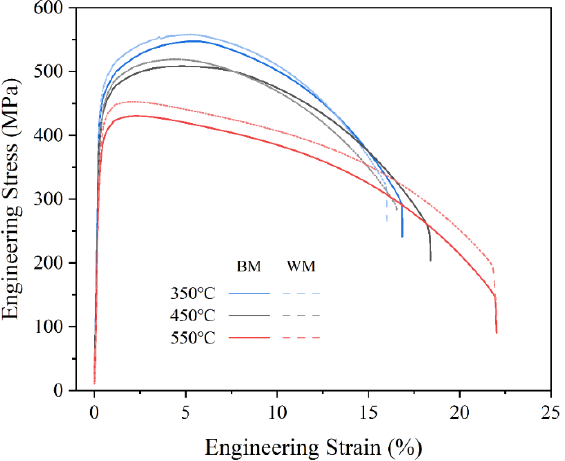
Figure 3. Engineering stress–strain curves of 2.25Cr1Mo0.25V steel BM and WM at elevated temperatures. Table 2. Tensile properties of 2.25Cr1Mo0.25V steel BM and WM at high temperatures.